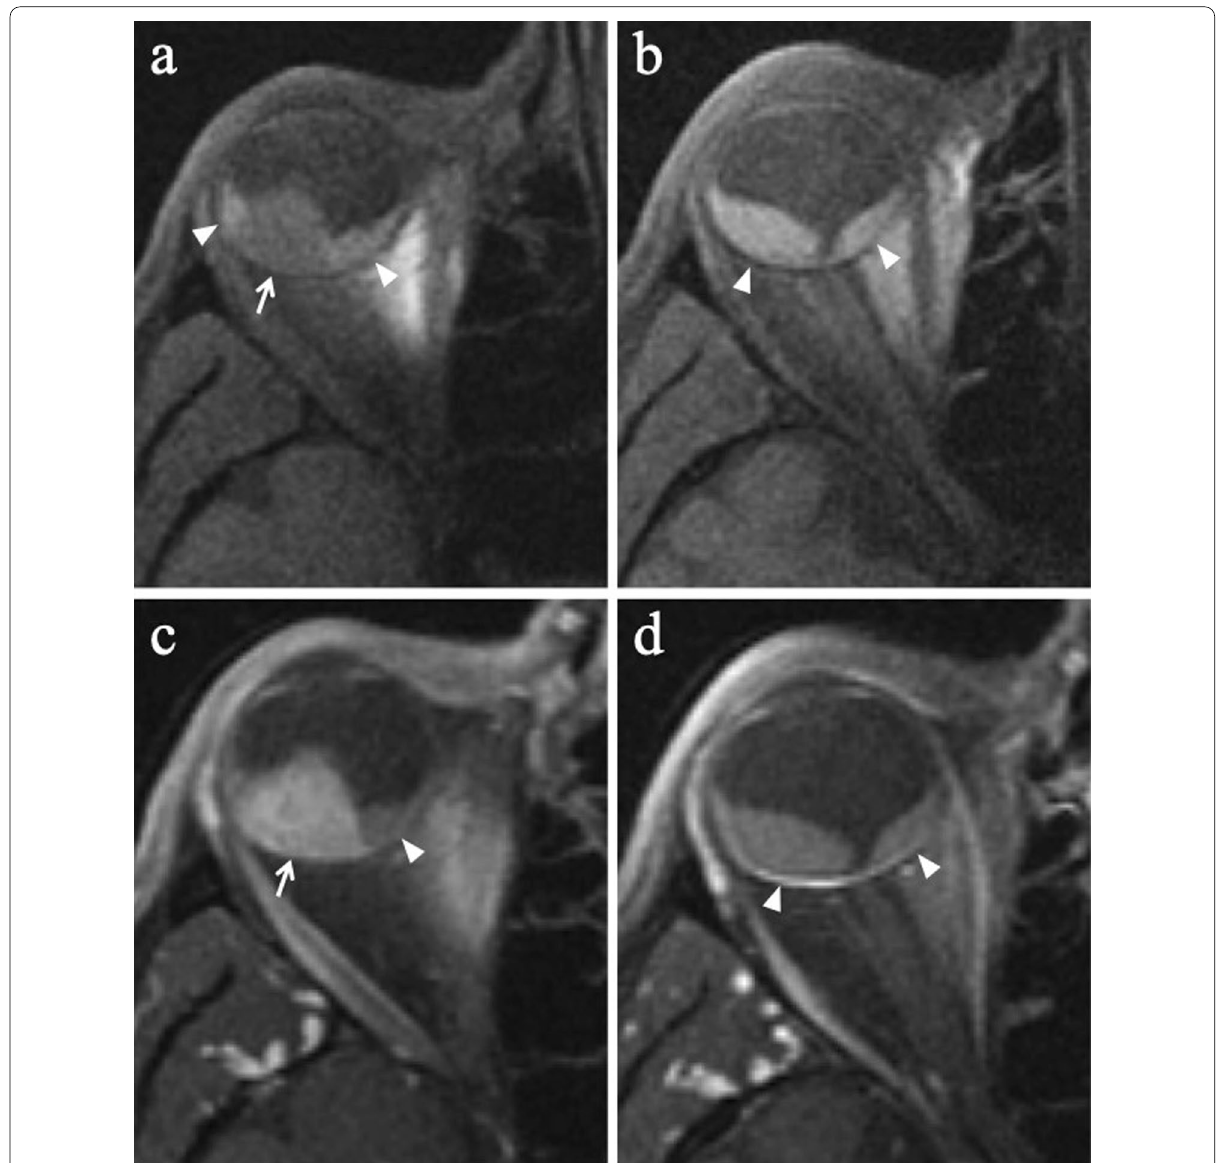
a ), displaying intermediate signal intensity because of low melanin content. A hemorrhagic retinal detachment, exhibiting the typical biconvex lentiform shape, is appreciable along the posterior aspect of globe (white arrowheads in b) and on both sides of the lesion (white arrowheads in a ); the retinal detachment shows high signal intensity because of subacute hemorrhagic content. On ( c, d ) axial contrast-enhanced fat-suppressed T1-weighted images the choroidal melanoma exhibits vivid enhancement (white arrow in c ), whereas the hemorrhagic retinal detachment